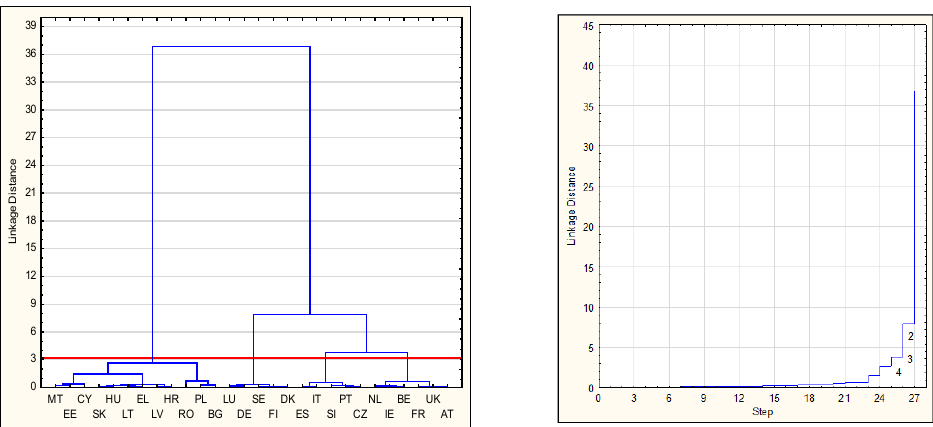
Figure 3. Dendrogram of connections, integration distances, and classification stages using Ward’s method for the EU countries. Source: authors’ compilation based on [3–5] using STATISTICA 13.1 statistical package. Note. Codes for EU countries: Austria (AT), Belgium (BE), Bulgaria (BG), Cyprus (CY), Czech Republic (CZ), Germany (DE), Denmark (DK), Estonia (EE), Greece (EL), Spain (ES), Finland (FI), France (FR), Croatia (HR), Hungary (HU), Ireland (IE), Italy (IT), Lithuania (LT), Luxembourg (LU), Latvia (LV), Malta (MT), Netherlands (NL), Poland (PL), Portugal (PT), Romania (RO), Sweden (SE), Slovenia (SI), Slovakia (SK), and the United Kingdom (UK). The red line indicates the cut-off level. Based on the analysis of the obtained results, the EU countries were divided into four relatively homogeneous classes using the k-means method. The final classification results are presented in Table 3 and Figure 4. Table 3. Classification of the European Union countries based on the Eco-Innovation Index value and the Summary Innovation Index value in the years 2013–2019 (EU average = 100). Average Distance No. Typology of Classes Class Composition Class Size from the Middle of